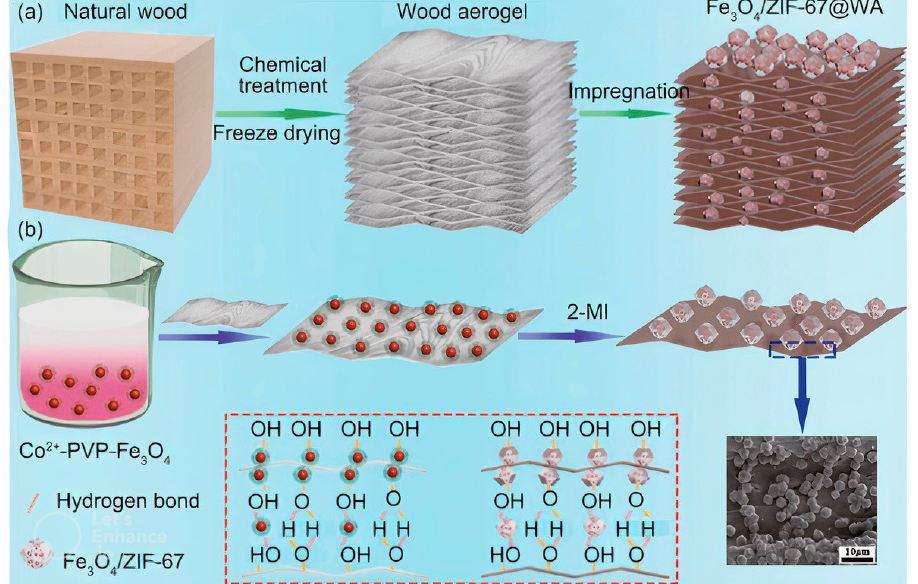
Figure 4. Process of Fe 3 O 4 /ZIF-67@WA aerogel preparation ( a ) Converting natural wood to Fe 3 O 4 /ZIF-67@WA; ( b ) Final properties of Fe 3 O 4 /ZIF-67@WA, reproduced with permission from [109]. Copyright Elsevier, 2019.